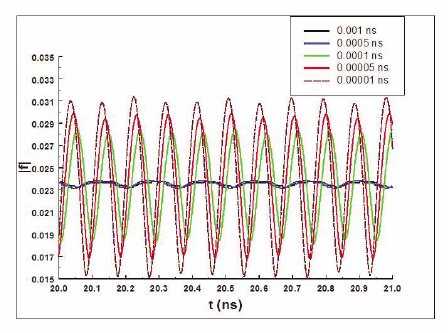
Figure 3. | f | as a function of time t for different dimensional temporal steps. Here the dimensionless time scale is equal 50, δ ω = 0 . 046565, I = 0 . 002249, Δ = 0 . 538374, γ = 1 . 193498, L = 113 .